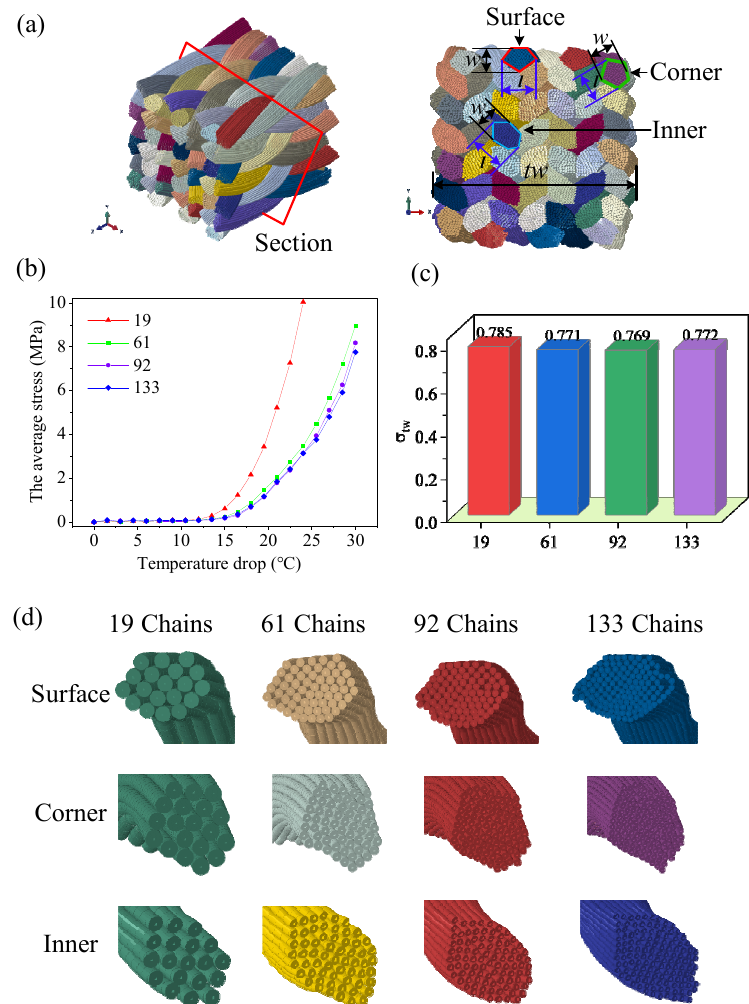
Figure 12. Geometrical convergence of the simulation models: ( a ) the cross-section of the preform after shrinkage, ( b ) the average stress curve of all virtual fibers, ( c ) the ratio of total width before and after deformation, and ( d ) the geometrical convergence of the cross-section shapes against the number of sub-yarns.